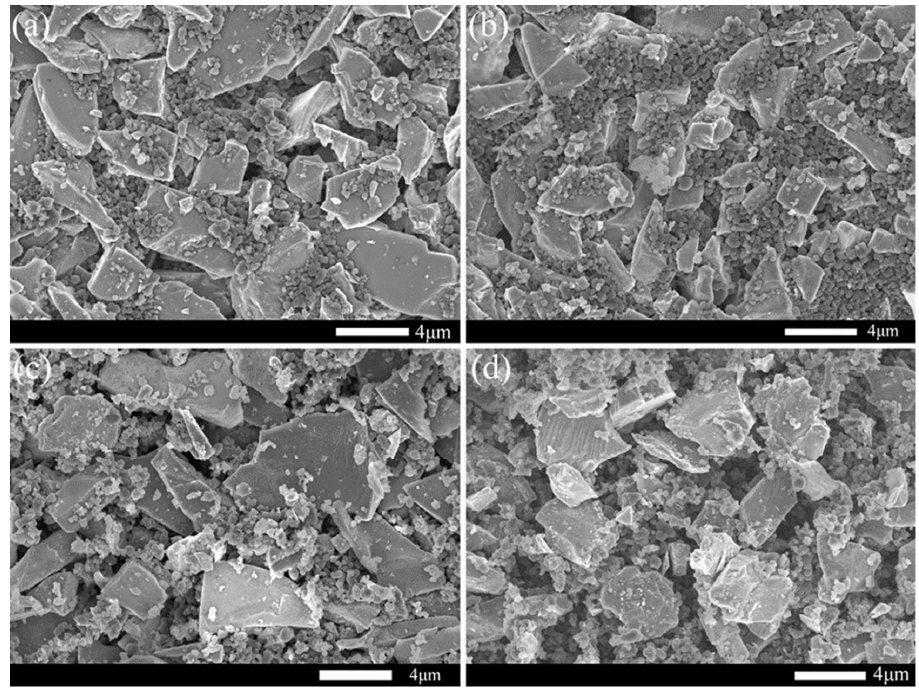
Figure 5. SEM micrographs of preforms ( a ) 4 wt%CB, ( b ) 6 wt%CB, ( c ) 8 wt%CB and ( d ) 10 wt%CB.